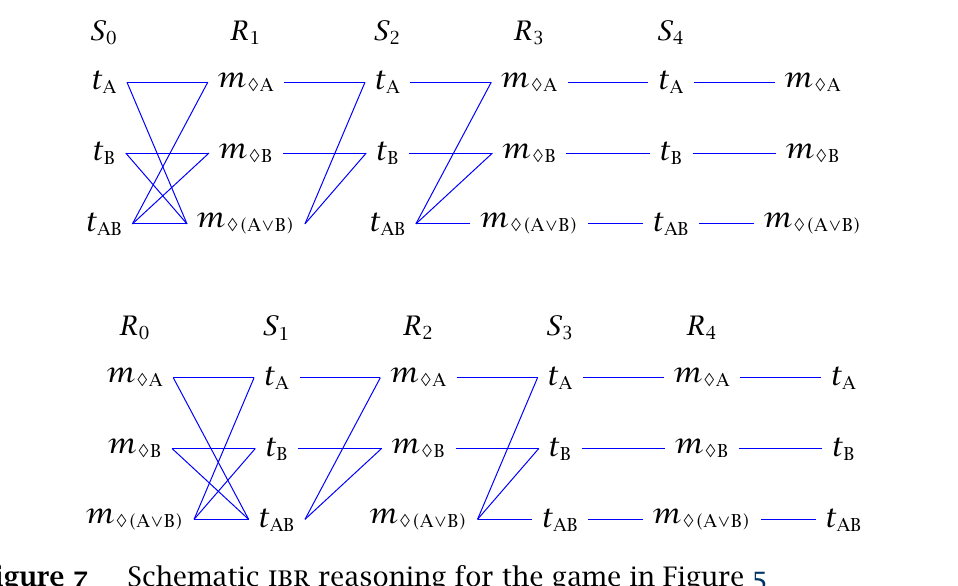
IBR reasoning with non-flat